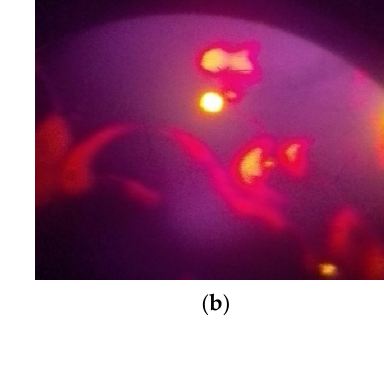
Figure 10. Differential scanning calorimeter curves of waste plastic/rubber-modified asphalt.